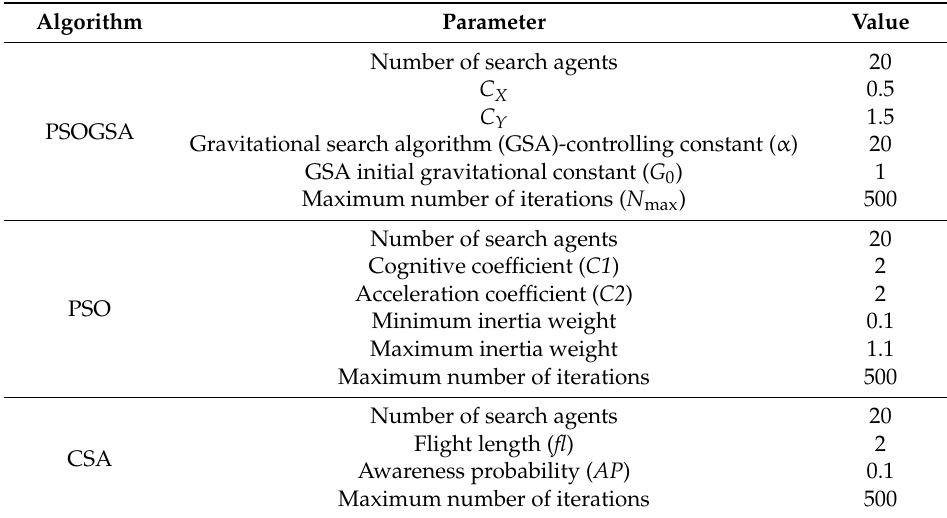
Table 1. Numerical values of the parameters